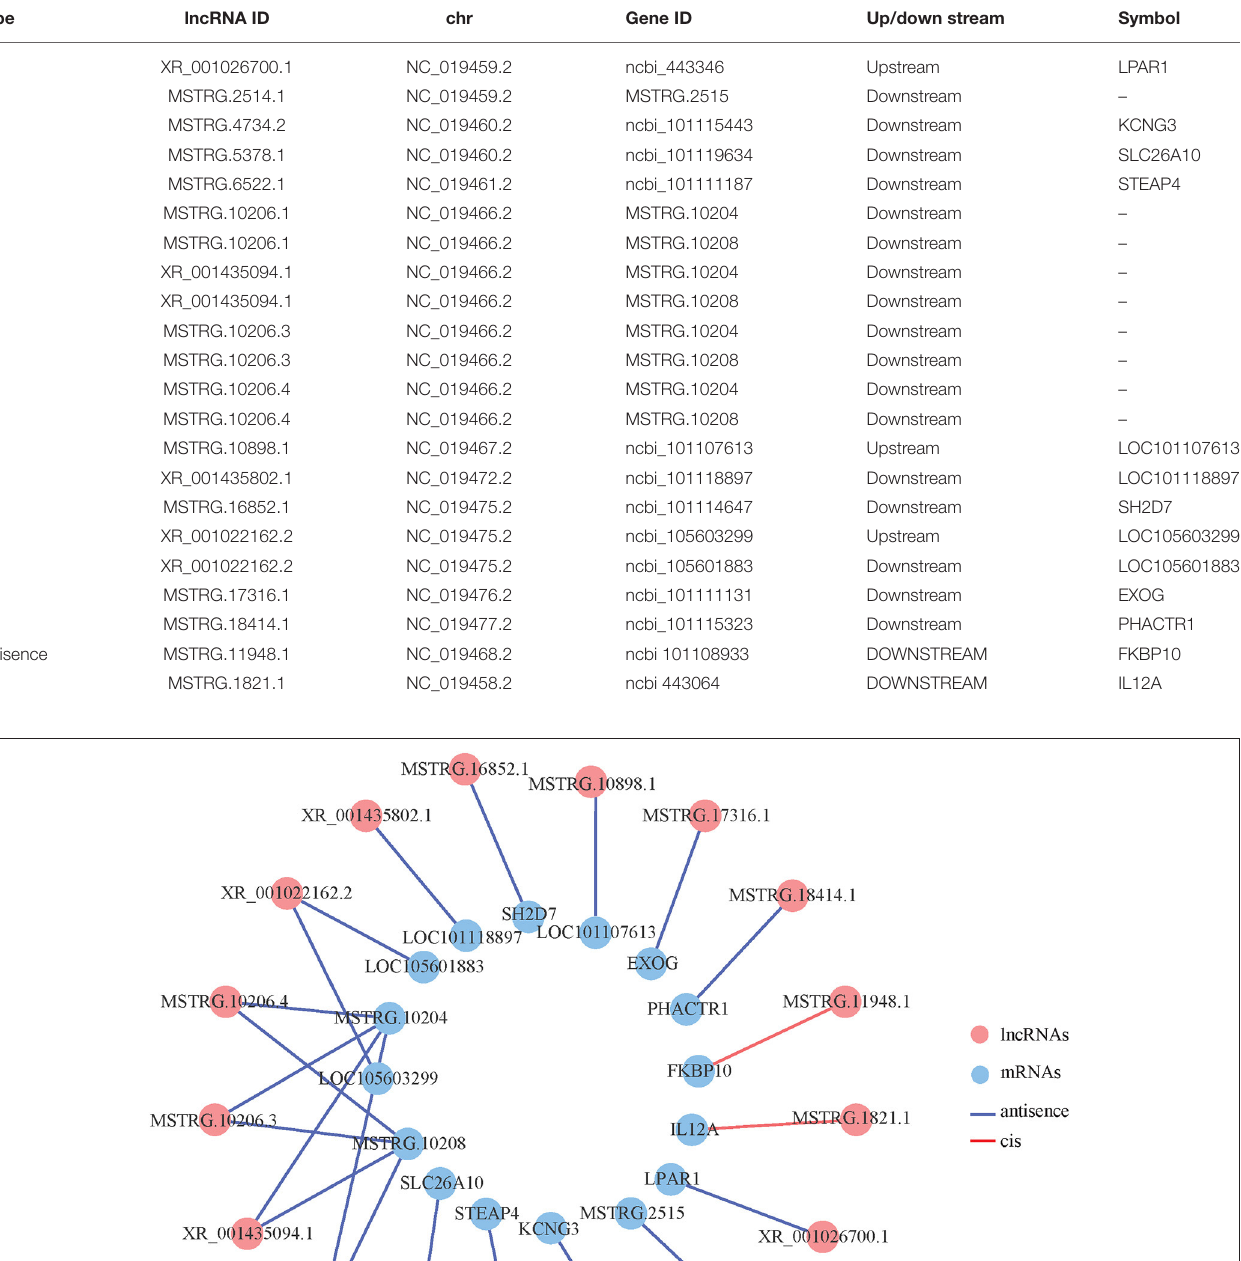
TABLE 2 | Differentially expressed lncRNAs and their targeted mRNAs.